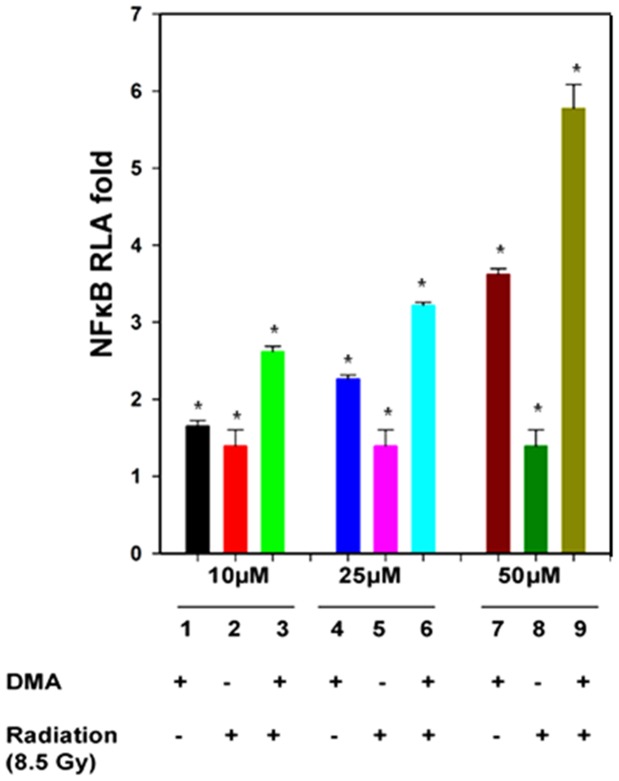
Luciferase assays for NFκB activation in U87 cells.Cells were co-transfected with pNFκB-Luc and pRenilla. After 24 h, cells were irradiated (8.5 Gy) with or without DMA treatment (50 µM) and stimulated with TNF-α (20 ng/ml) for 4 h prior to cell lysis. Luciferase activity was determined to quantify NFκB transcription activity. Relative Luciferase activity (RLA) for NFκB activation was increased in DMA treated cells compared with irradiated or control cells. The triplicate samples were used and the data was presented as mean±SD from three independent experiments. (*indicates statistical significance by T-test, *p<0.00001).